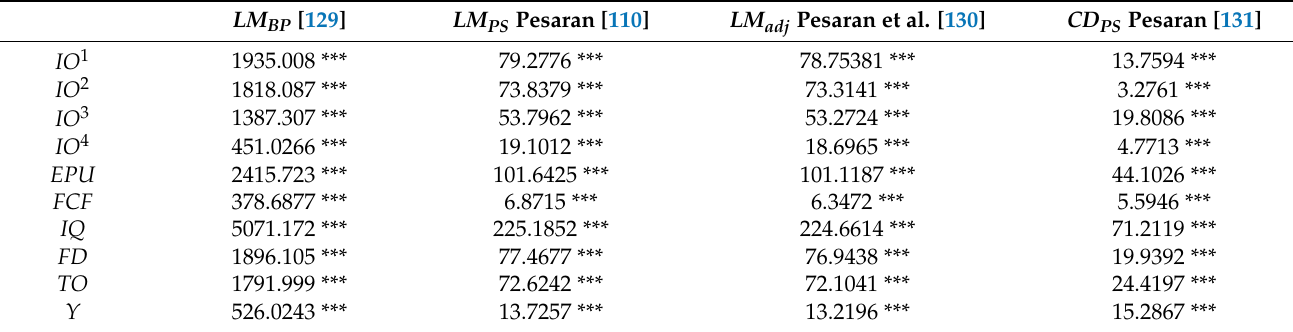
Table 7. Cross-sectional dependency test.